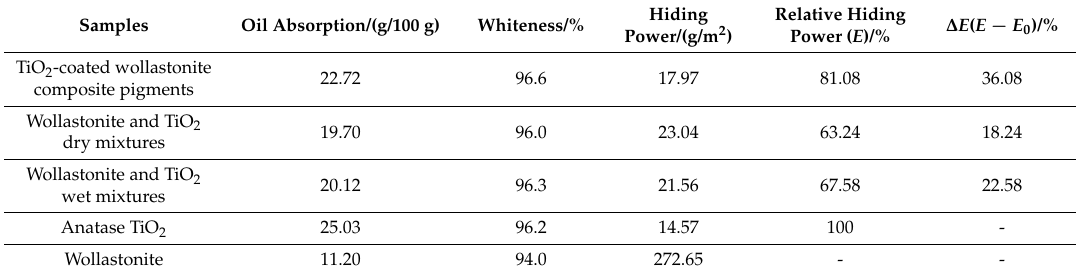
Table 1. The main properties of TiO 2 -coated wollastonite composite pigments and comparison.